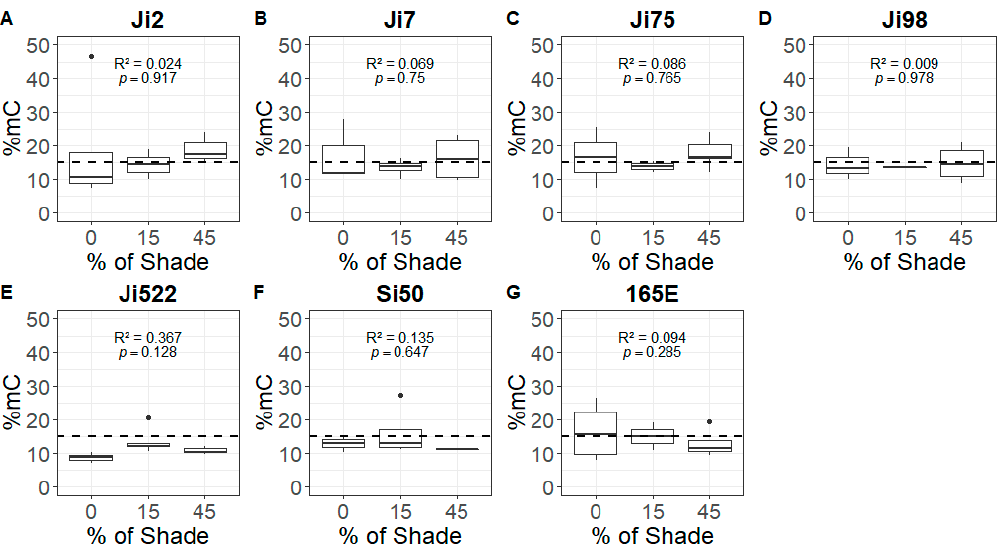
Figure 2. Global DNA methylation variation with shade in highly inbred lines of A. majus. Global DNA methylation percentages (%mC) as a function of shade treatments for every highly inbred line: Ji2 ( A ), Ji7 ( B ), Ji75 ( C ), Ji98 ( D ), Ji522 ( E ), Si50 ( F ), and 165E ( G ). The dashed line represents the mean %mC (14.92%). Coe ffi cients of determinations (R 2 ) and test probabilities ( p ) are given for each test of the relationship between the %mC and shade. N = 105 (five plants × three shade treatments × seven lines); each boxplot represents the mean and standard error for five